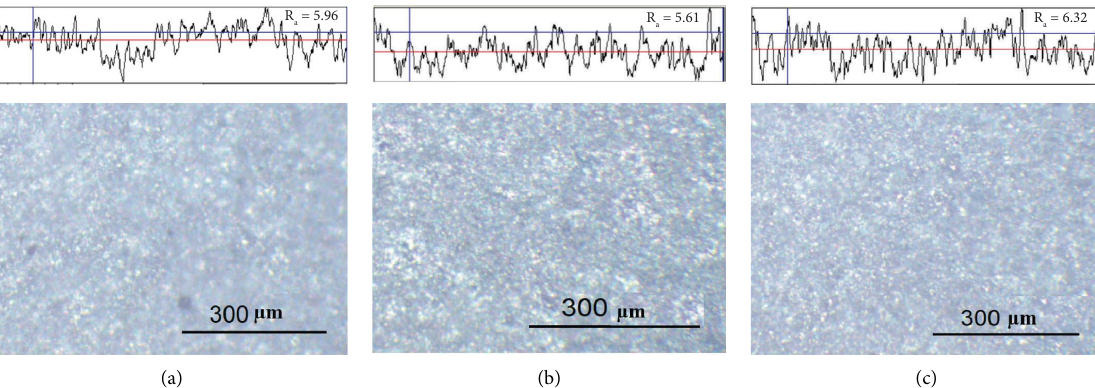
Figure 4: Microphotographs and surface roughness profle of Cr 73%.